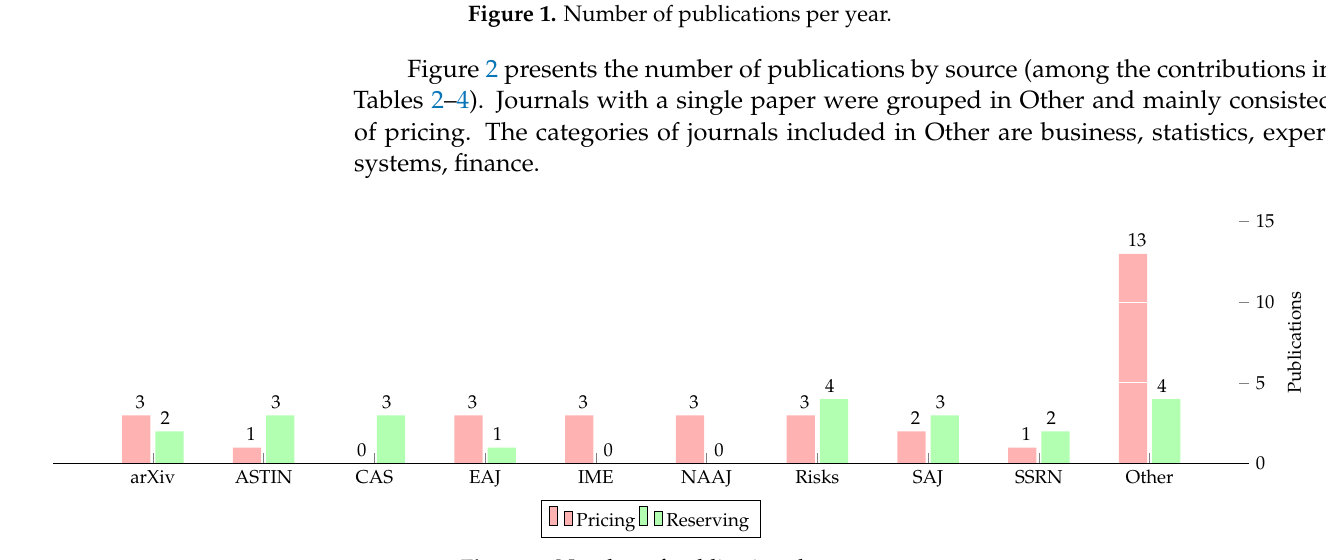
Figure 2. Number of publications by